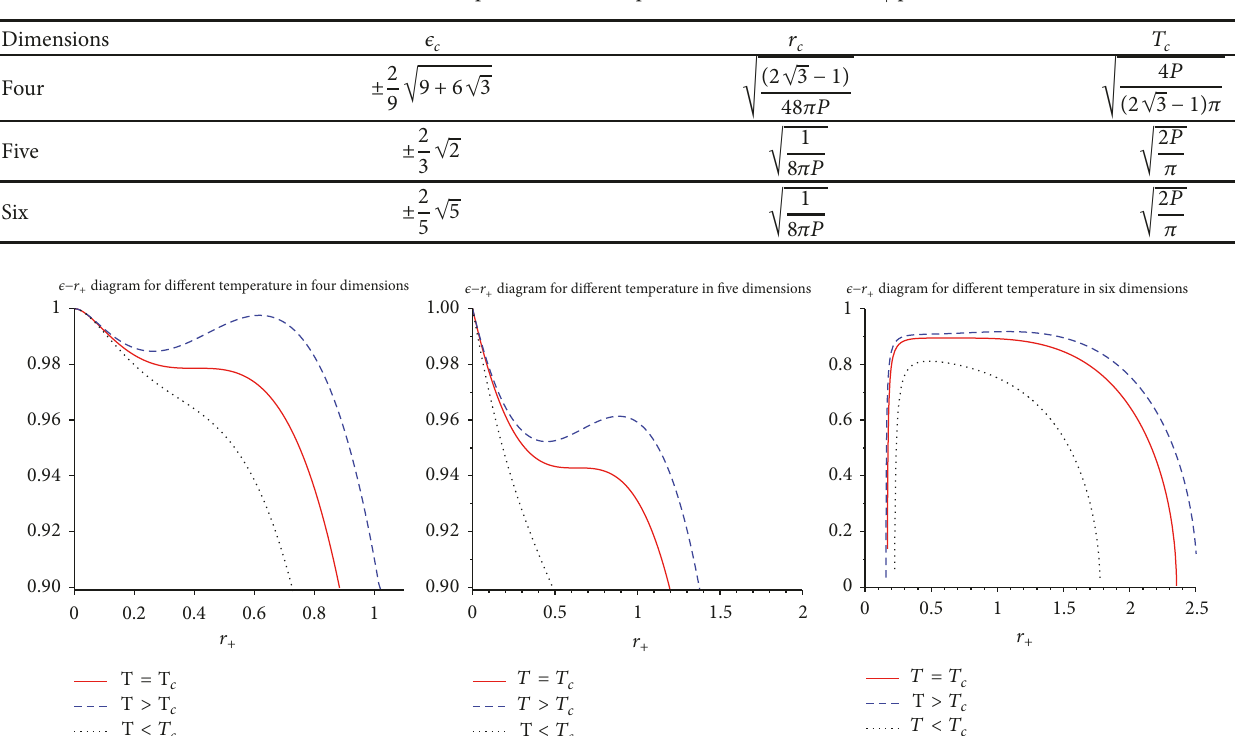
Table 2: The critical point of HL AdS spherical black holes in 𝜖 − 𝑟 + plane.